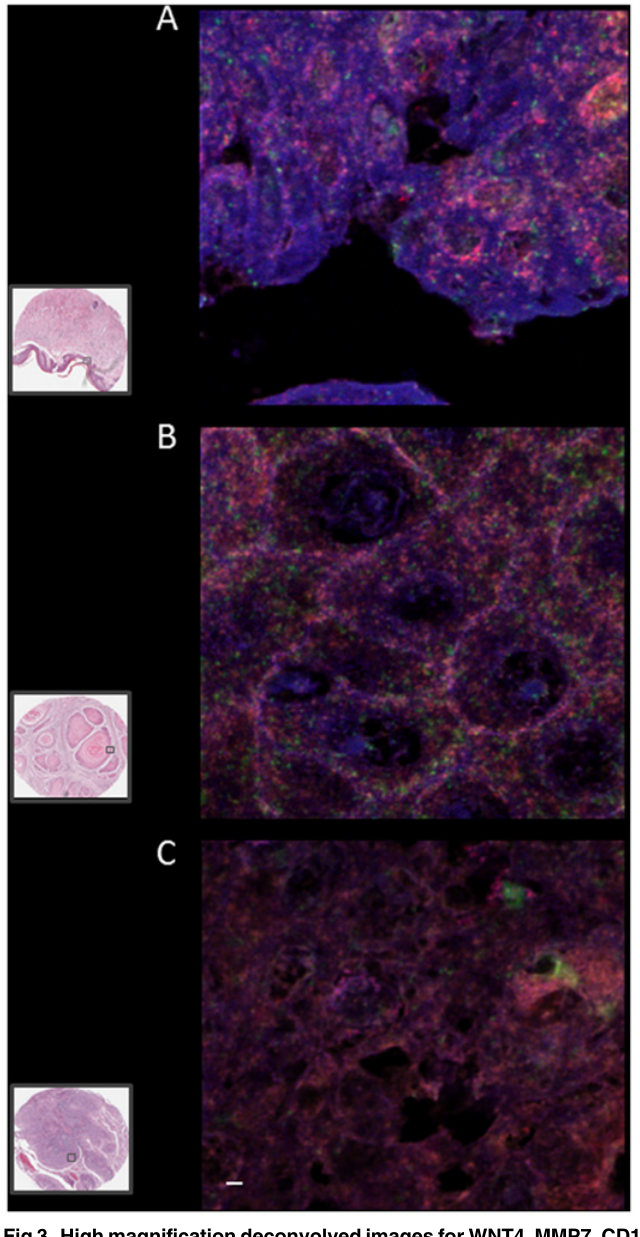
Fig 3. High magnification deconvolved images for WNT4, MMP7, CD1 and c-MYC co-expression in control and malignant penile tissue. Composite, representative, micrographs of immunofluorescently stained penile tissue cores used to quantify co-localization of four proteins WNT4 (Alexa 405-blue), MMP7 (FITC-green), CD1 (Cy3-orange) and c-MYC (Cy5-red) after deconvolution. Tissue cores from 8 patients (control), 25 malignant tissue cores (11 grade I and 14 grade II) were imaged using an Olympus FV1000 confocal microscope. High magnification imaging (at 1024x1024 resolution) was performed for deconvolution analysis using Huygens Profesional software. Areas of squamous cell carcinoma in malignant tissue cores were identified, visually (see box) from a serial H&E section of the tissue, and imaged at high magnification (40x with 4 – 6x zoom). Two representative immunofluorescently labelled cores are shown: A is control and B and C are grade I and grade II, squamous cell carcinoma samples, respectively; Inset is H&E serial sections of at low magnification. High magnification images were deconvolved to reduce noise and converted to 16bit tif files for each fluorophore (Alexa Fluor-405, FITC, Cy3 and Cy5) were imported into Huygens deconvolution software and pseudo colored (FITC, green; Alexa Fluor-405, blue; Cy3, orange; and Cy5, red). Z-projections for up to 53 images for each tissue core. Representative images of controls and malignant carcinoma samples are shown. Scale bar = 3 μ m. High magnification images were used for quantitative co-localization